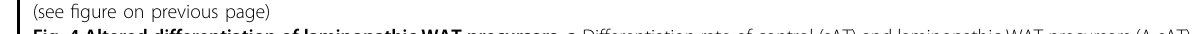
Fig. 4 Altered differentiation of laminopathic WAT precursors. a Differentiation rate of control (sAT) and laminopathic WAT precursors (A-sAT) is shown in the upper graph. Lipid droplet diameter frequency in sAT and A-sAT adipocytes at day 9 of differentiation. Data are percentage of total counted vesicles (300 per sample in three different samples). b Representative images of cultured sAT and A-sAT living cells at day 9 in WAT medium (phase-contrast living cells) and electron microscopy images are shown (electron microscopy). L, lipid droplets. Bars, 10 μ m for phase-contrast pictures, 1 μ m for electron microscopy. c Quanti fi cation of PPAR γ 1, PPAR γ 2, and UCP1 mRNA expression by qRT-PCR in sAT and A-sAT cells under basal conditions (ND) or exposed to WAT differentiation medium for 9 days (WAT). d Western blotting, and densitometric analysis ofPPAR γ 1, PPAR γ 2 and UCP1 in sAT and A-sAT cells under basal conditions (ND) or exposed to WAT differentiation medium for 9 days (WAT). The actin band is shown as a protein loading control. e Western blotting and densitometric analysis of TOM20 in sAT and A-sAT cells under basal conditions (ND) or exposed to WAT differentiation medium for 9 days (WAT). The actin band is shown as a protein loading control. The number of mitochondria per cell in the corresponding samples as measured by electron microscopy analysis is reported in the right graph. f Quantitative RT-PCR analysis of BAT markers DIO2 , PRDM16 , and UCP1 in control or FPLD2 white adipocyte precursors. Three biological replicates were used in each experiment as well as in qRT- PCR analyses. Data are means of three independent experiments ± SD. Molecular weight markers in d and e are reported in kDa. Statistically signi fi cant differences ( p < 0.05) between control and corresponding FPLD2 samples are indicated by an asterisk